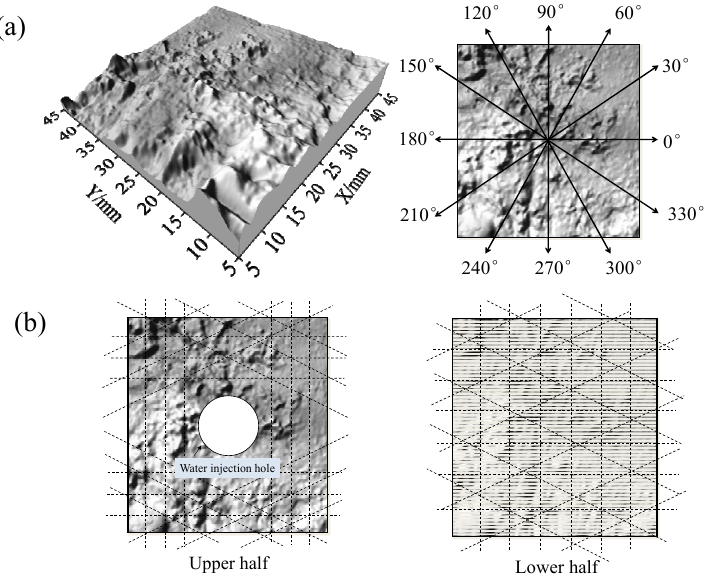
Figure 10. Scheme used to calculate the JRC of the structural plane showing the ( a ) direction used and ( b ) extracted profiles associated with different directions.